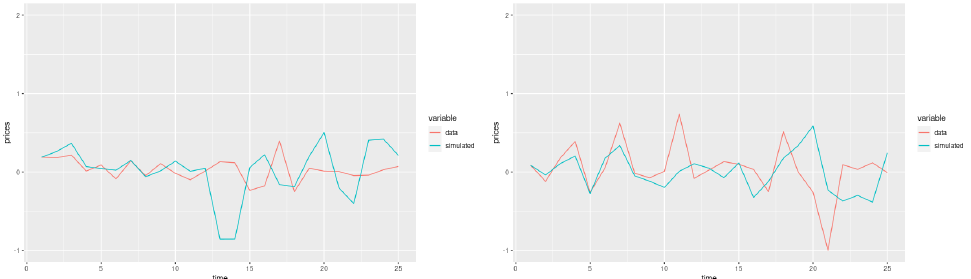
Figure 9. Price trajectories generated by the model (54) vs. the copper price data. Temporal ranges: (iii) on the left and (iv) on the right.